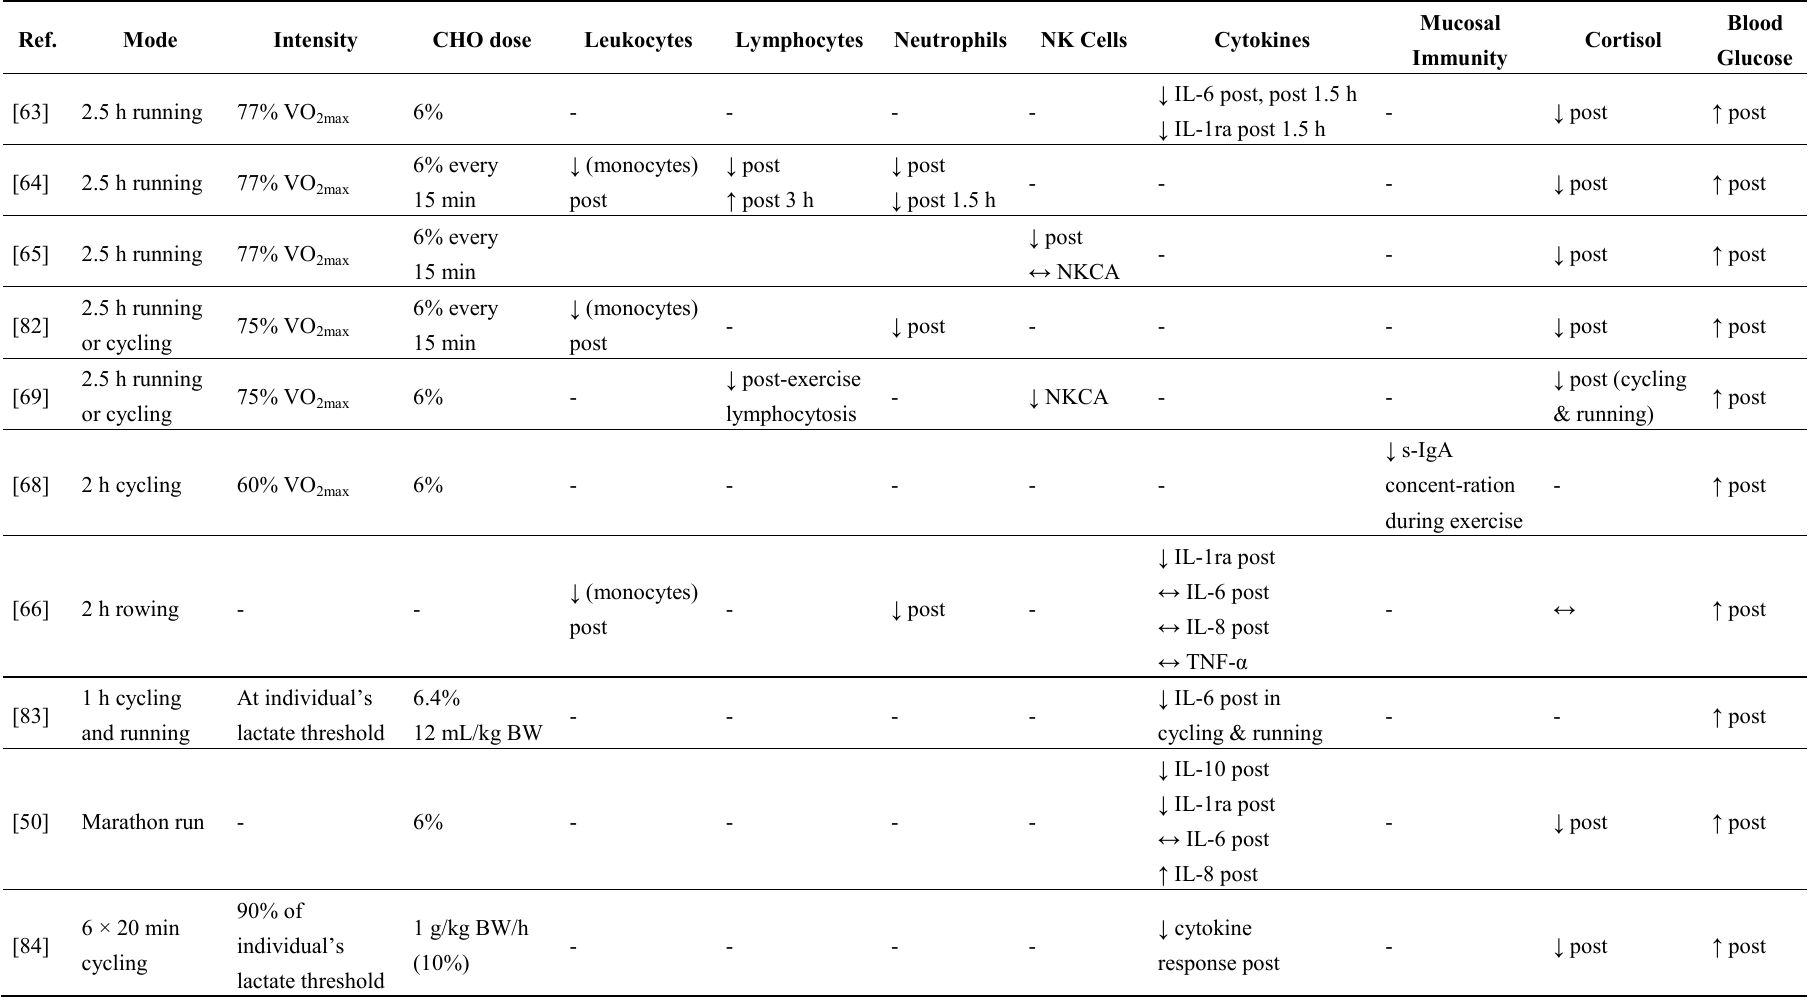
Table 2. Effects of CHO supplementation during exercise on selected immune variables relative to control. (↑: significant increase; ↓: significant decrease; ↔: no difference; -: not tested/not accessible; post: post-exercise; Wmax: maximal power; TT: time trial; PLA: control group; Ref.: